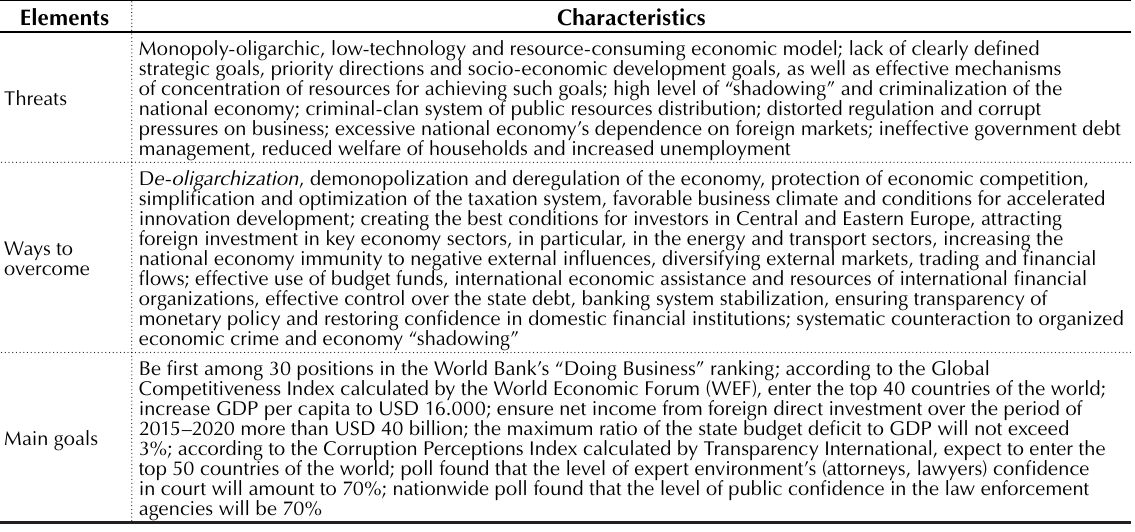
Table 1. Economic development goals, key threats to Ukraine’s economic security and ways to overcome them Sourse: the National Security Strategy of Ukraine, the Sustainable Development Strategy “Ukraine –